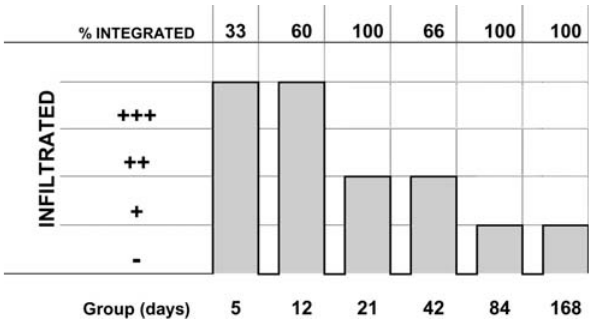
FIGURE 10 - Histologic exam with integration frequency and infiltrated presence, by group, in keloid grafted fragments. Graphic